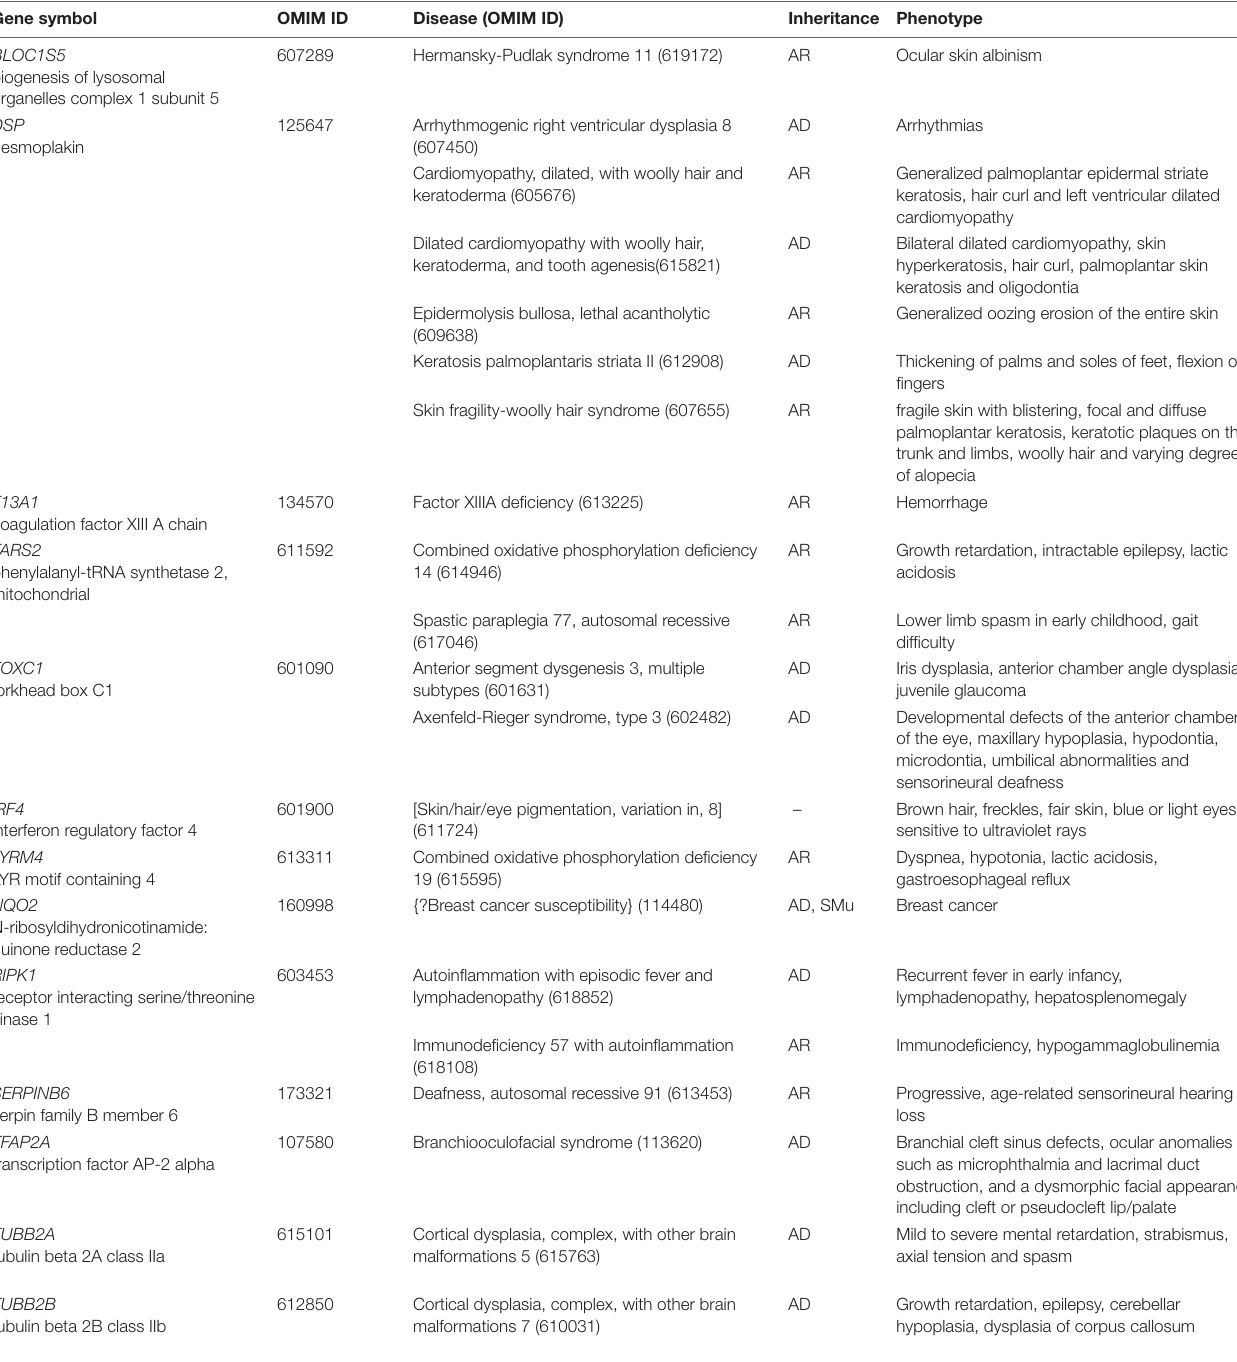
TABLE 2 | Summary of OMIM genes in